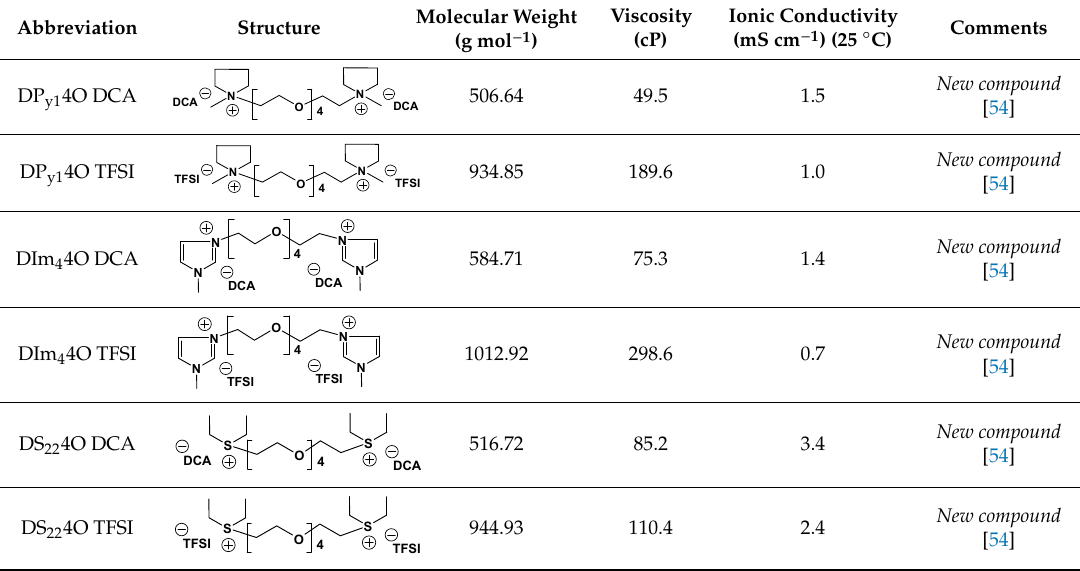
Table 6. Properties of dicationic ionic liquids (DILs).